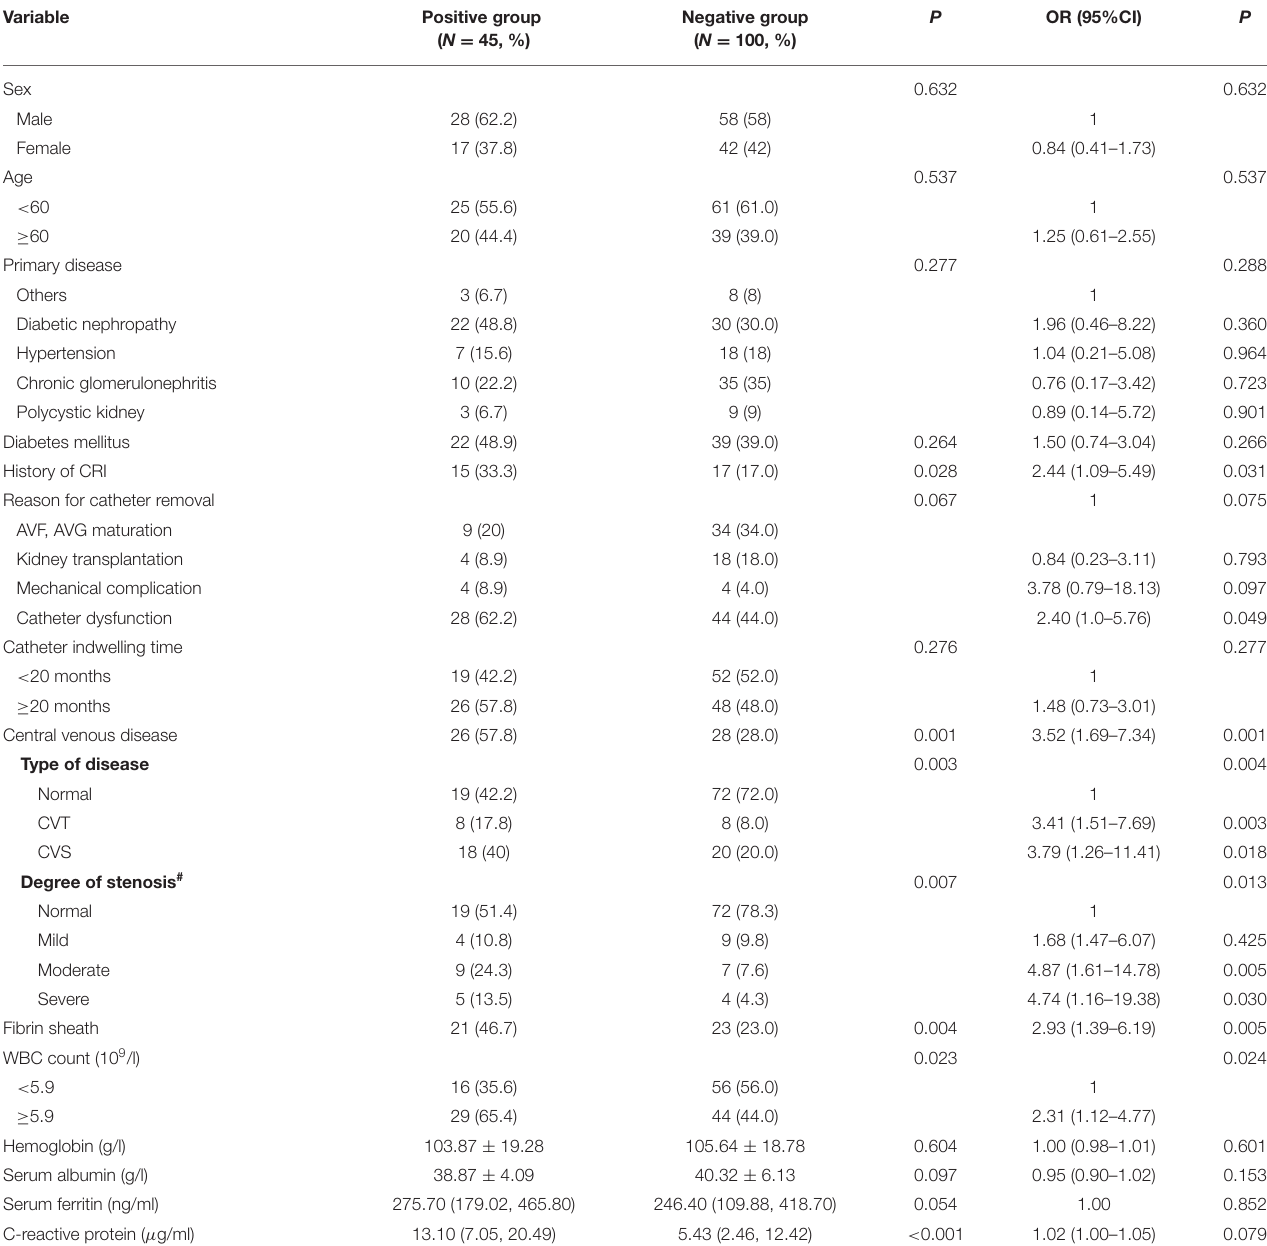
TABLE 1 | Clinical and laboratory data of patients in this retrospective cohort study.